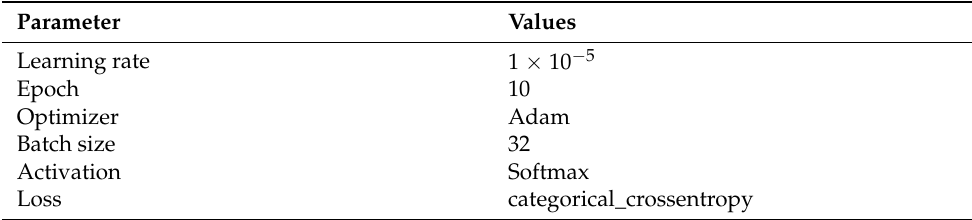
Table 6. Parameter setting of Word2vec with CNN, RNN, and